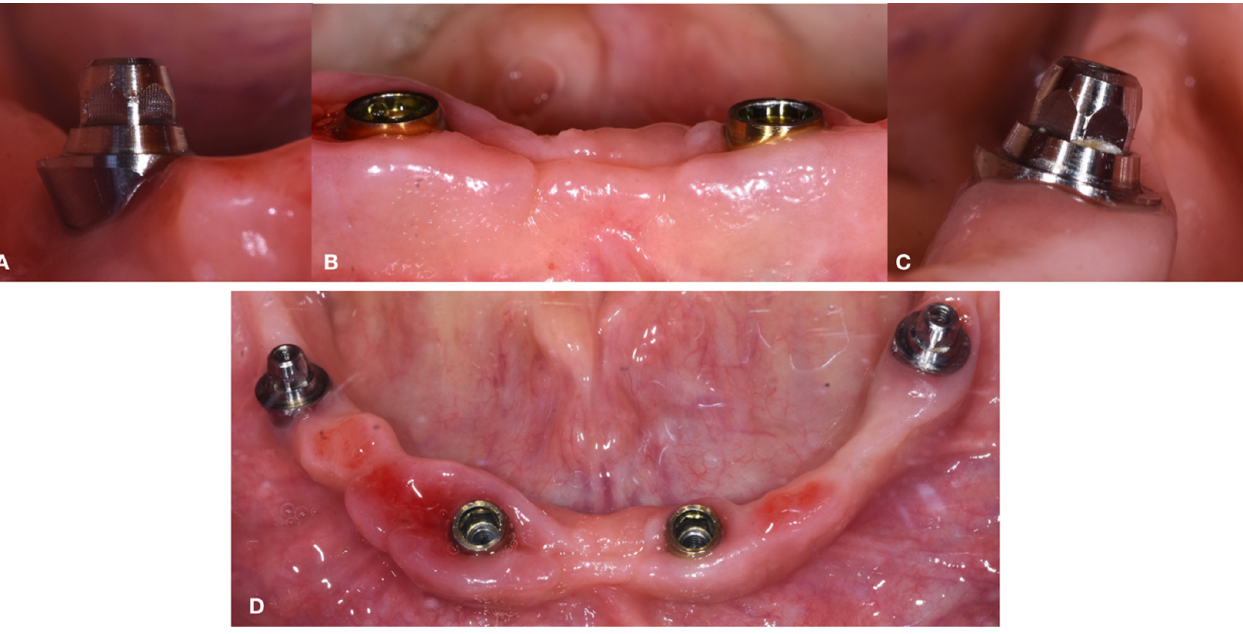
Figure 12. Details of soft tissue healed after 24 months. (March 2022) ( A ). Distal right implant. ( B ) Anterior implants. ( C ) Distal left implant. ( D ) Occlusal view.